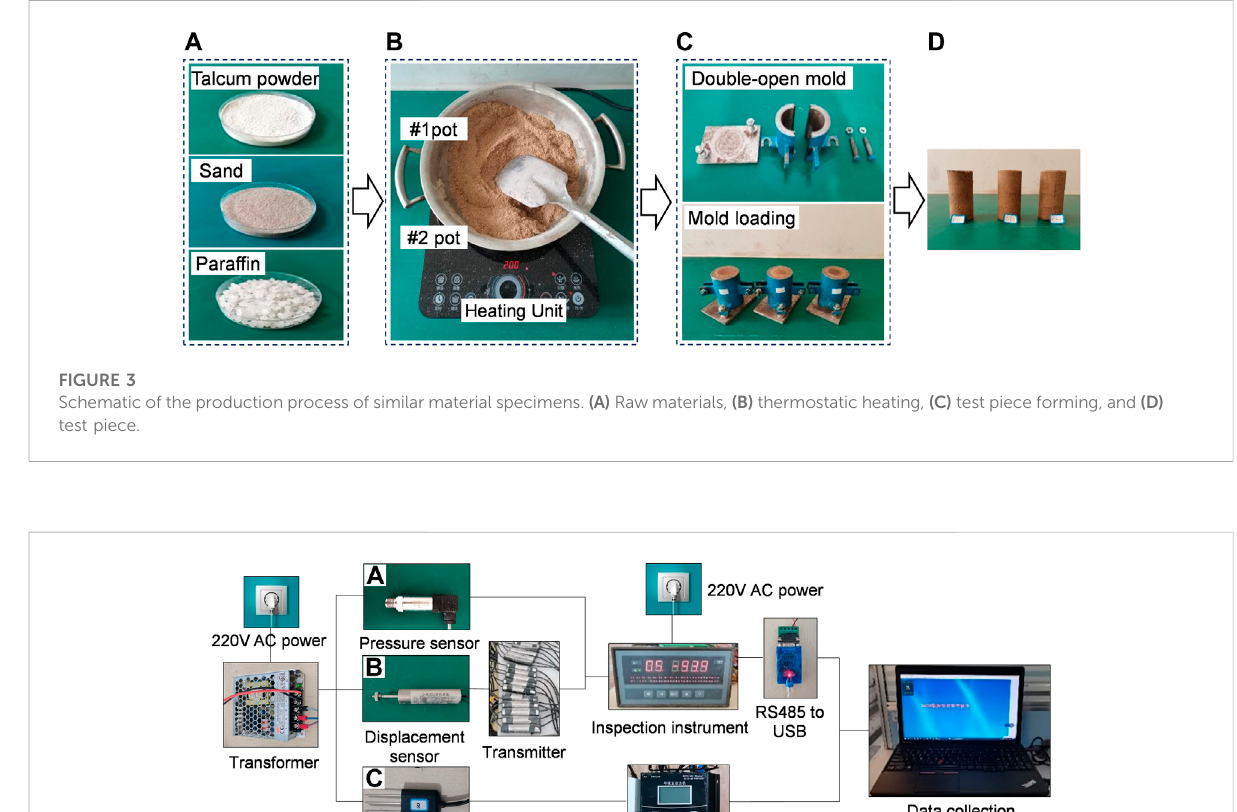
(Figure 1A) adopted a modular design. The similarity ratio between (Figure 1B) and actual slurry injection working